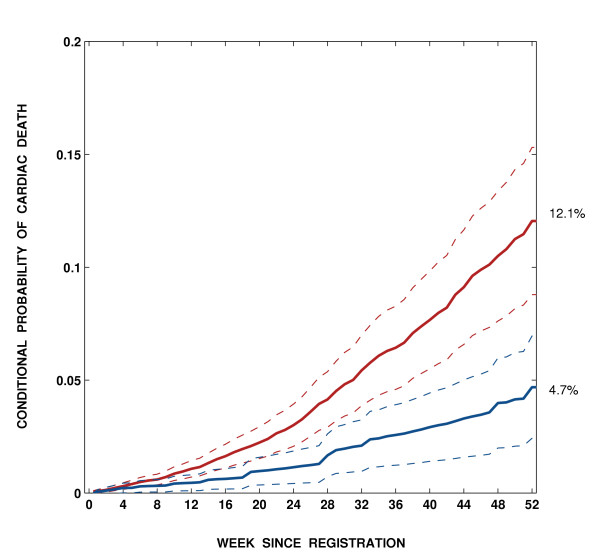
Estimated conditional probability for cardio-vascular death and 95% confidence intervals, by week since registration in high-severity (red) and low-severity (blue) groups; two-sample test = 3.6, p < 0.001.